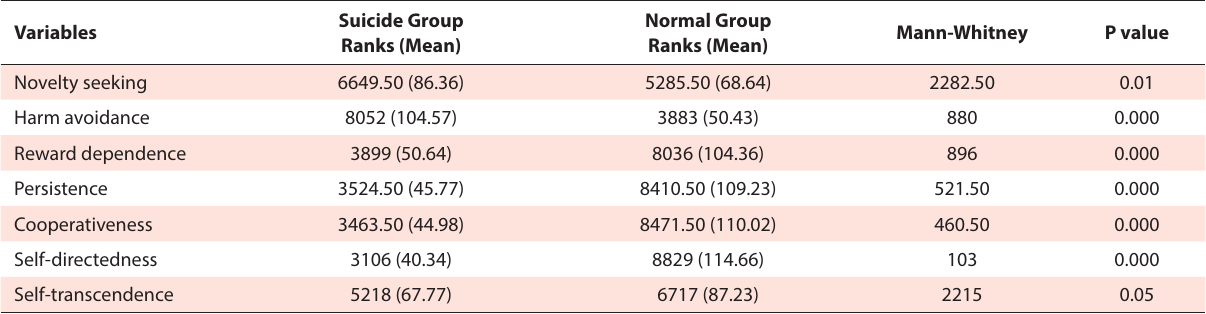
Table 3. The mean of the Cloninger’s Temperament and Character Inventory test variables